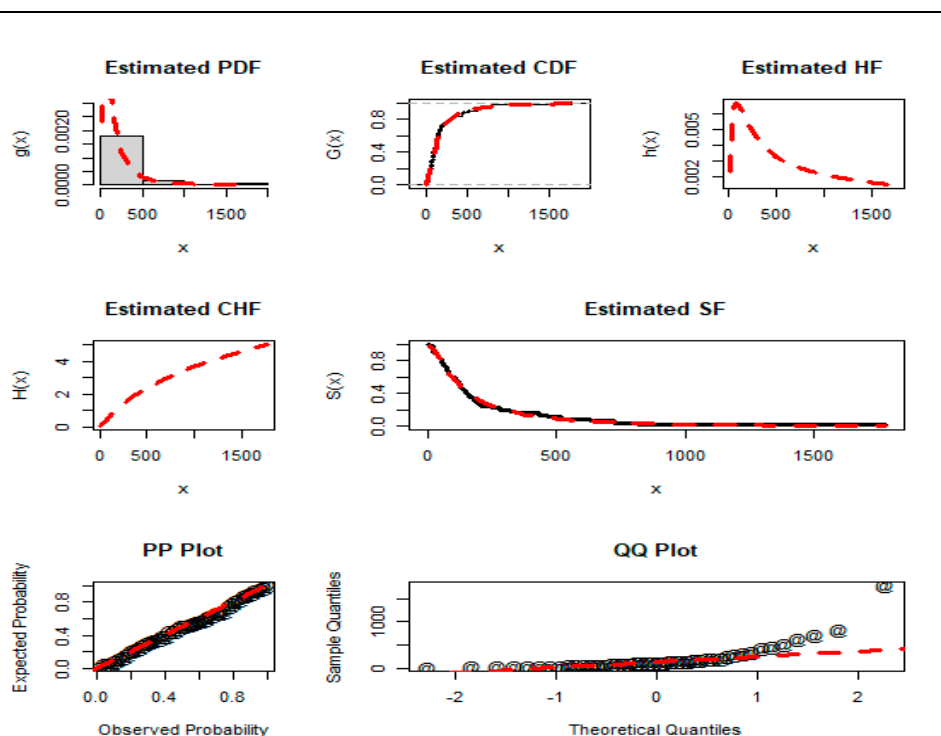
Figure 7. Estimated PDF, CDF, HF, CHF, SF, PP plot and QQ plot of the NGLog–Weib distribution for dataset 2.